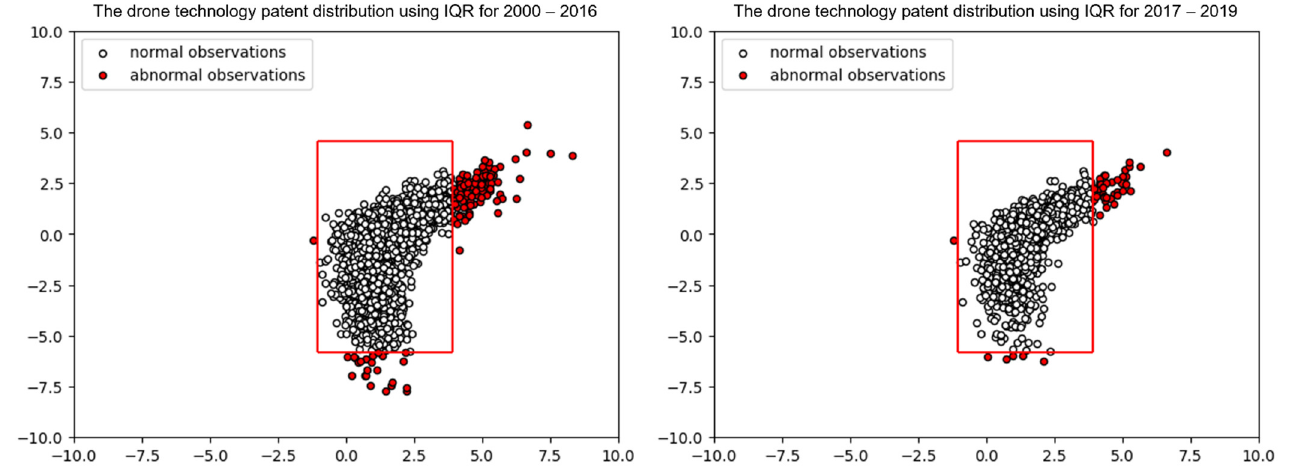
Figure 6. The result of document embedding (IQR).